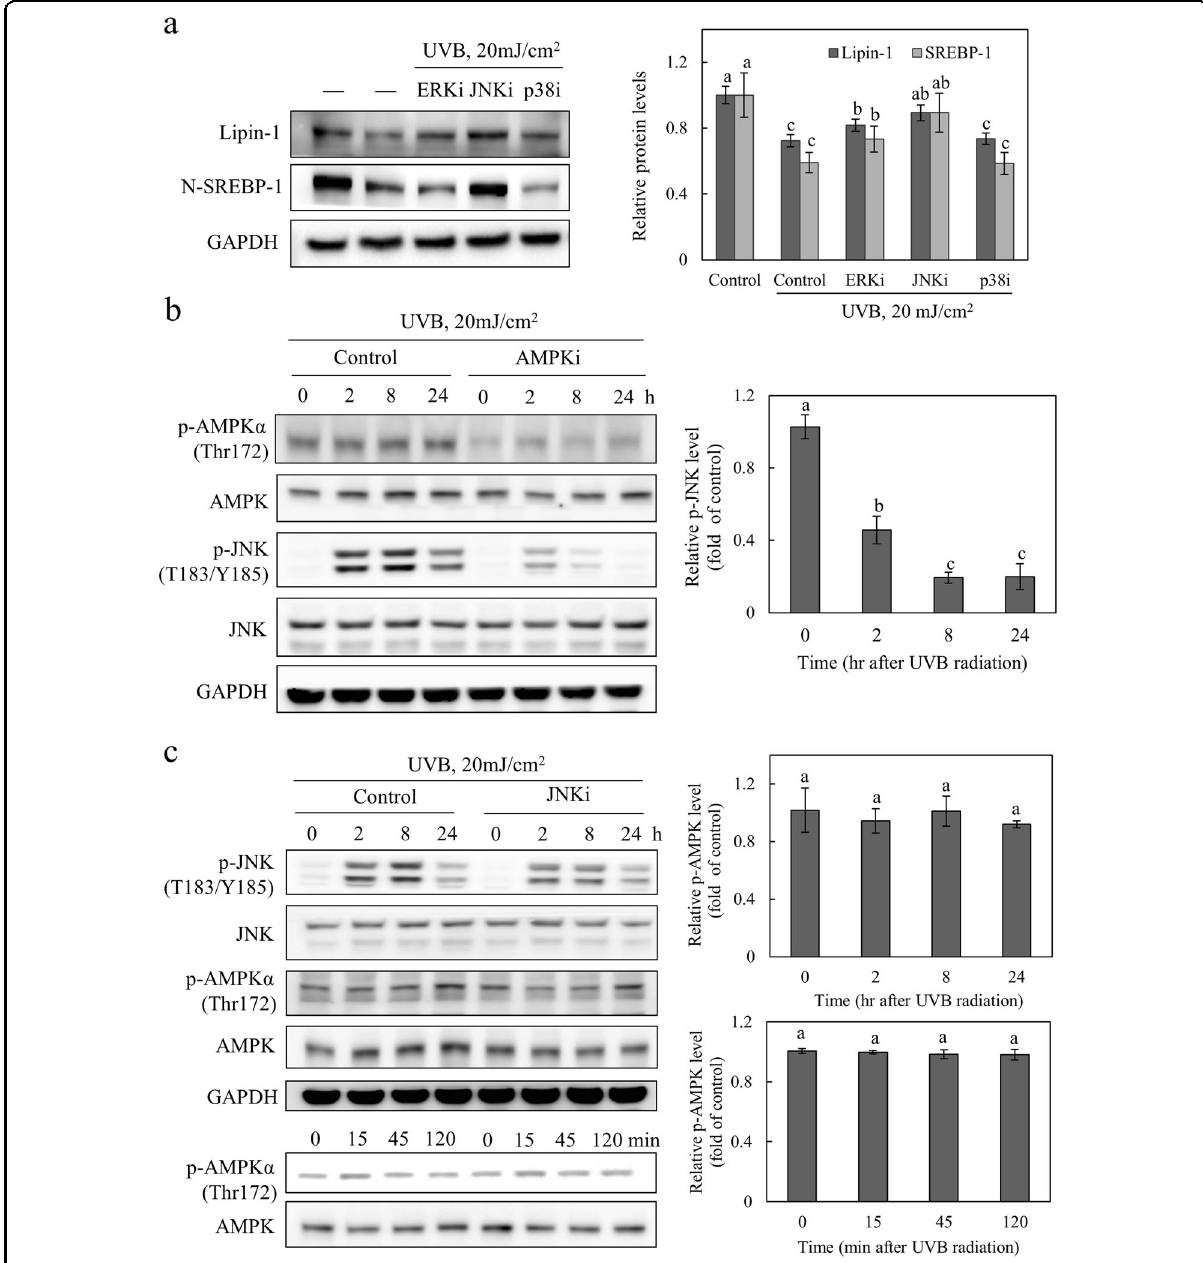
Fig. 4 UVB-induced JNK activation depends on AMPK activation and mediates lipin-1 inhibition. a NHEKs were pretreated with the ERK (PD98059, 25 μ M), p38 MAPK (SB203580, 1 μ M), or JNK (SP600125, 5 μ M) inhibitor for 15 min, followed by exposure to 20 mJ/cm 2 UVB, and incubated for 24 h. Lipin-1 or N-SREBP-1 levels were detected by western blotting and normalized to GAPDH. b NHEKs were pretreated with the AMPK inhibitor (compound C, 10 μ M) for 15 min, exposed to 20 mJ/cm 2 UVB, and cultured for 0, 2, 8, and 24 h. p-AMPK (Thr172), AMPK, p-JNK (T132/Y185), and JNK levels were detected by western blotting. The levels of phosphorylated JNK (T132/Y185) were normalized to JNK, and the expression of normalized p-JNK relative to that of the control was analyzed at 0, 2, 8, and 24 h after exposure to UVB. c NHEKs that were pretreated with the JNK inhibitor (SP600125, 5 μ M) for 15 min were exposed to 20 mJ/cm 2 UVB and cultured for 0, 15, 45, and 120 min or 0, 2, 8, and 24 h. p-JNK (T132/Y185), JNK, p-AMPK (Thr172), and AMPK levels were detected by western blotting. The levels of phosphorylated AMPK (Thr172) were normalized to AMPK, and the expression of normalized p-AMPK relative to that of the control was analyzed at 0, 2, 8, and 24 h or 0, 15, 45, and 120 min after exposure to UVB. All data (mean ± SD) represent three independent experiments. Means without a common letter differ; P <